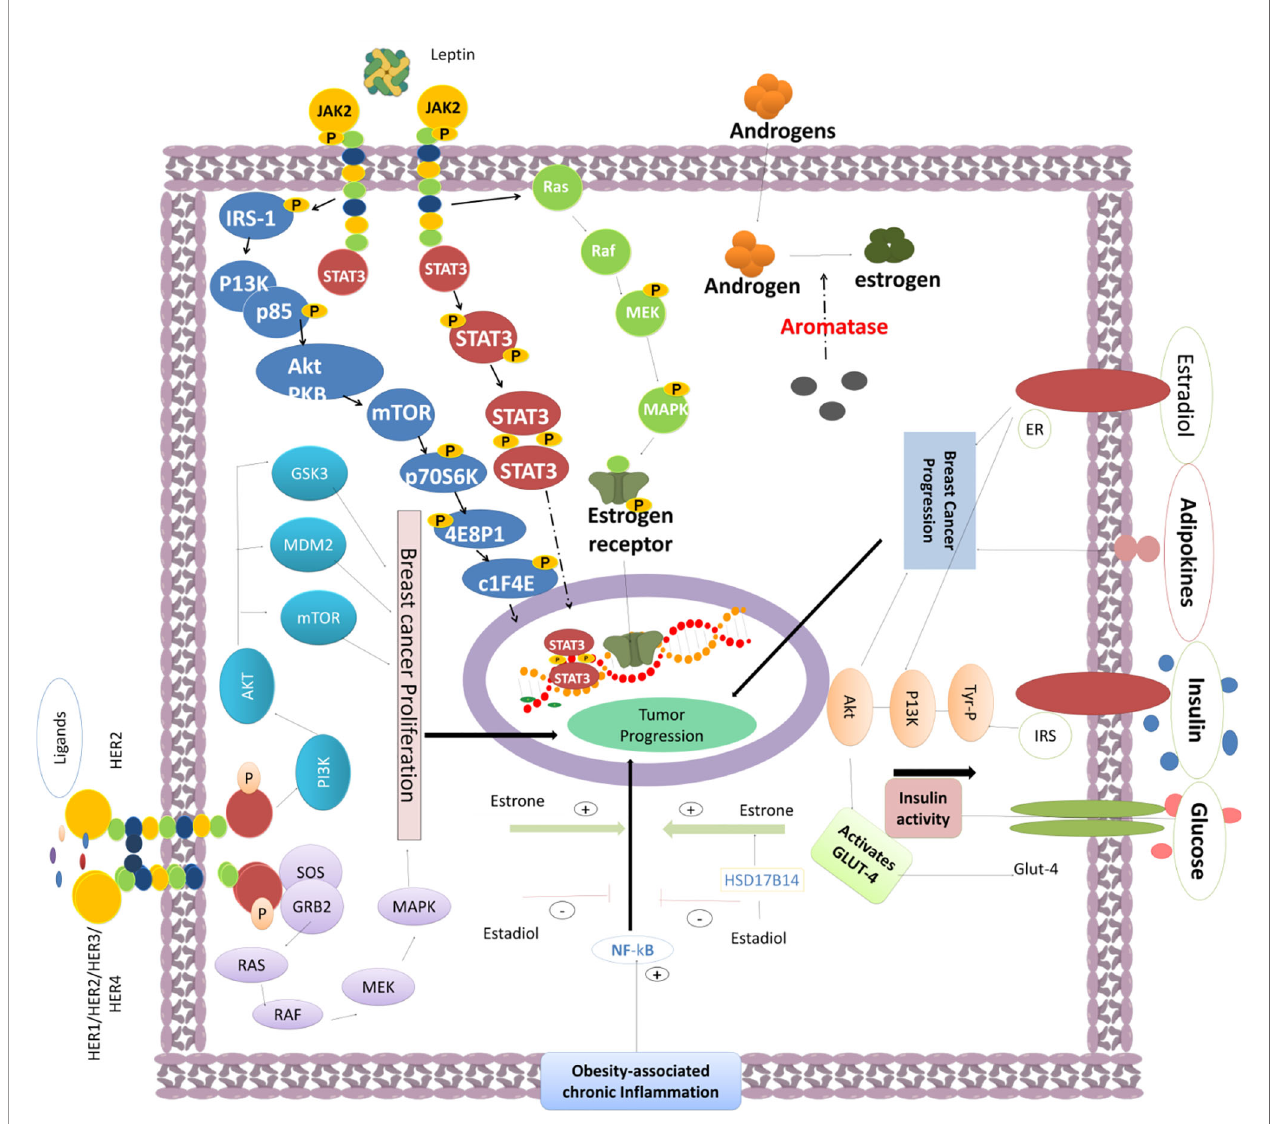
FIGURE 2 | The activity of various oncogenic pathways triggers BC epithelial cell proliferation and tumor progression. Obesity-induced chronic in fl ammation can promote the NF- k B signaling. Fat cell-produced estrone can enhance the activation of NF- k B and promote BC progression. Leptin can modulate the PI3K/AKT signaling through IRS-1, enhance mTOR activity, trigger 4EBP1 and elF4E phosphorylation, and mediate the STAT3-promoted gene transcription required for cancer cell growth. Furthermore, the JAK-STAT and MAPK pathways are enhanced by the leptin-induced JAK2 signaling. MEK phosphorylation strongly promotes gene expression for ef fi cient tumor progression. Aromatase activity promotes the androgen to estrogen conversion required for tumor progression. Other signaling effectors such as insulin, estradiol, adipokines, and high glucose can also enhance BC progression. Insulin can promote IRS and Tyr-P signaling and induce the activation of PI3K/AKT via stimulation of GLUT-4, which consequently enhances the glucose uptake into BC cells. Several HER1/HER2/HER3/HER4 ligands can enhance the activity of HER2, promote the tyrosine kinase domain phosphorylation, and induce BC progression through the signaling cascade mediated through the PI3K/AKT/mTOR and RAS-RAF-MEK-MAPK pathways to foster cell growth and